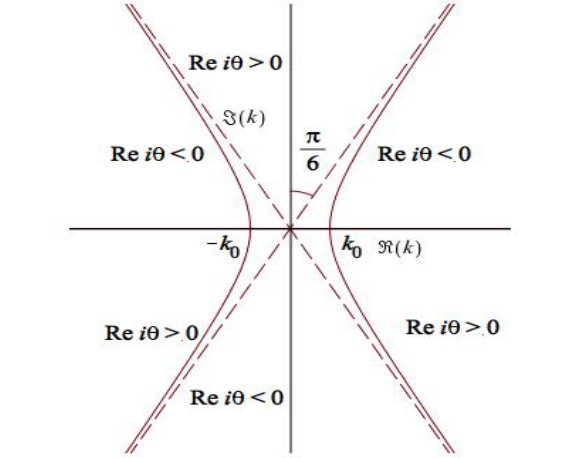
Figure 2. The signature table of Re i θ when x <